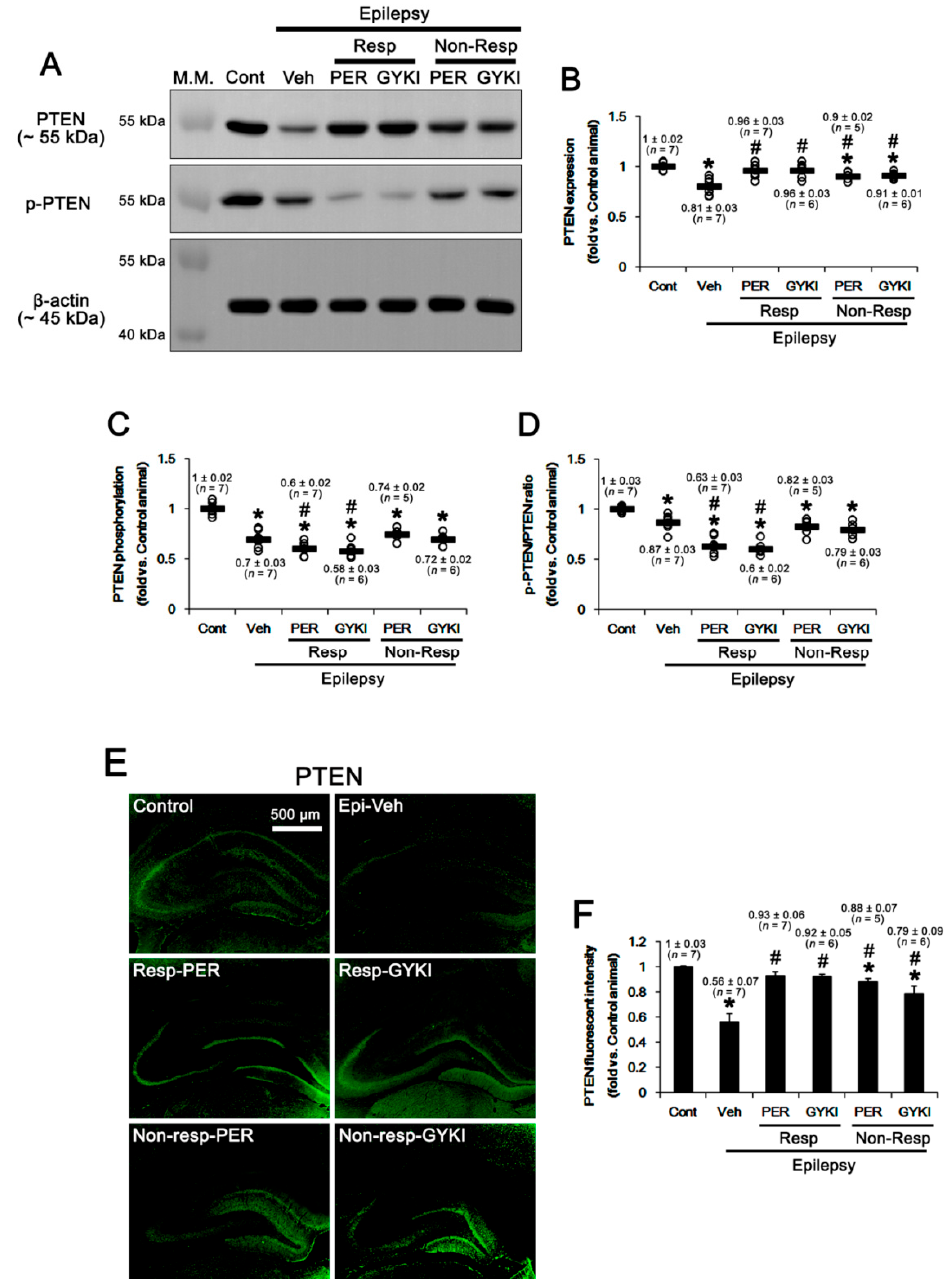
Figure 3. The e ff ects of perampanel (PER) and GYKI 52,466 (GYKI) on total phosphatase and tensin homolog deleted on chromosome 10 (PTEN) expression and its phosphorylation (p-PTEN) in chronic epilepsy rats. Both AMPAR antagonists increase PTEN expression in both responders (Resp) and non-responders (Non-Resp) but decrease its phosphorylation only in responders. ( A ) Representative images for Western blot of PTEN and p-PTEN levels in the hippocampal tissues. ( B – D ) Quantifications of PTEN ( B ), p-PTEN ( C ) and p-PTEN / PTEN ratio ( D ) levels in the hippocampal tissues. Open circles indicate each individual value. Horizontal bars indicate mean value. Error bars indicate SEM ( * , # p < 0.05 vs. control and vehicle (Veh)-treated animals, respectively; one-way ANOVA with post hoc Bonferroni’s multiple comparison). ( E ) Representative images for immunofluorescence of PTEN in the hippocampal tissues. ( F ) Quantifications of PTEN fluorescent intensity in the hippocampal tissues. Error bars indicate SEM ( * , # p < 0.05 vs. control and vehicle (Veh)-treated animals, respectively; one-way ANOVA with post hoc Bonferroni’s multiple comparison).